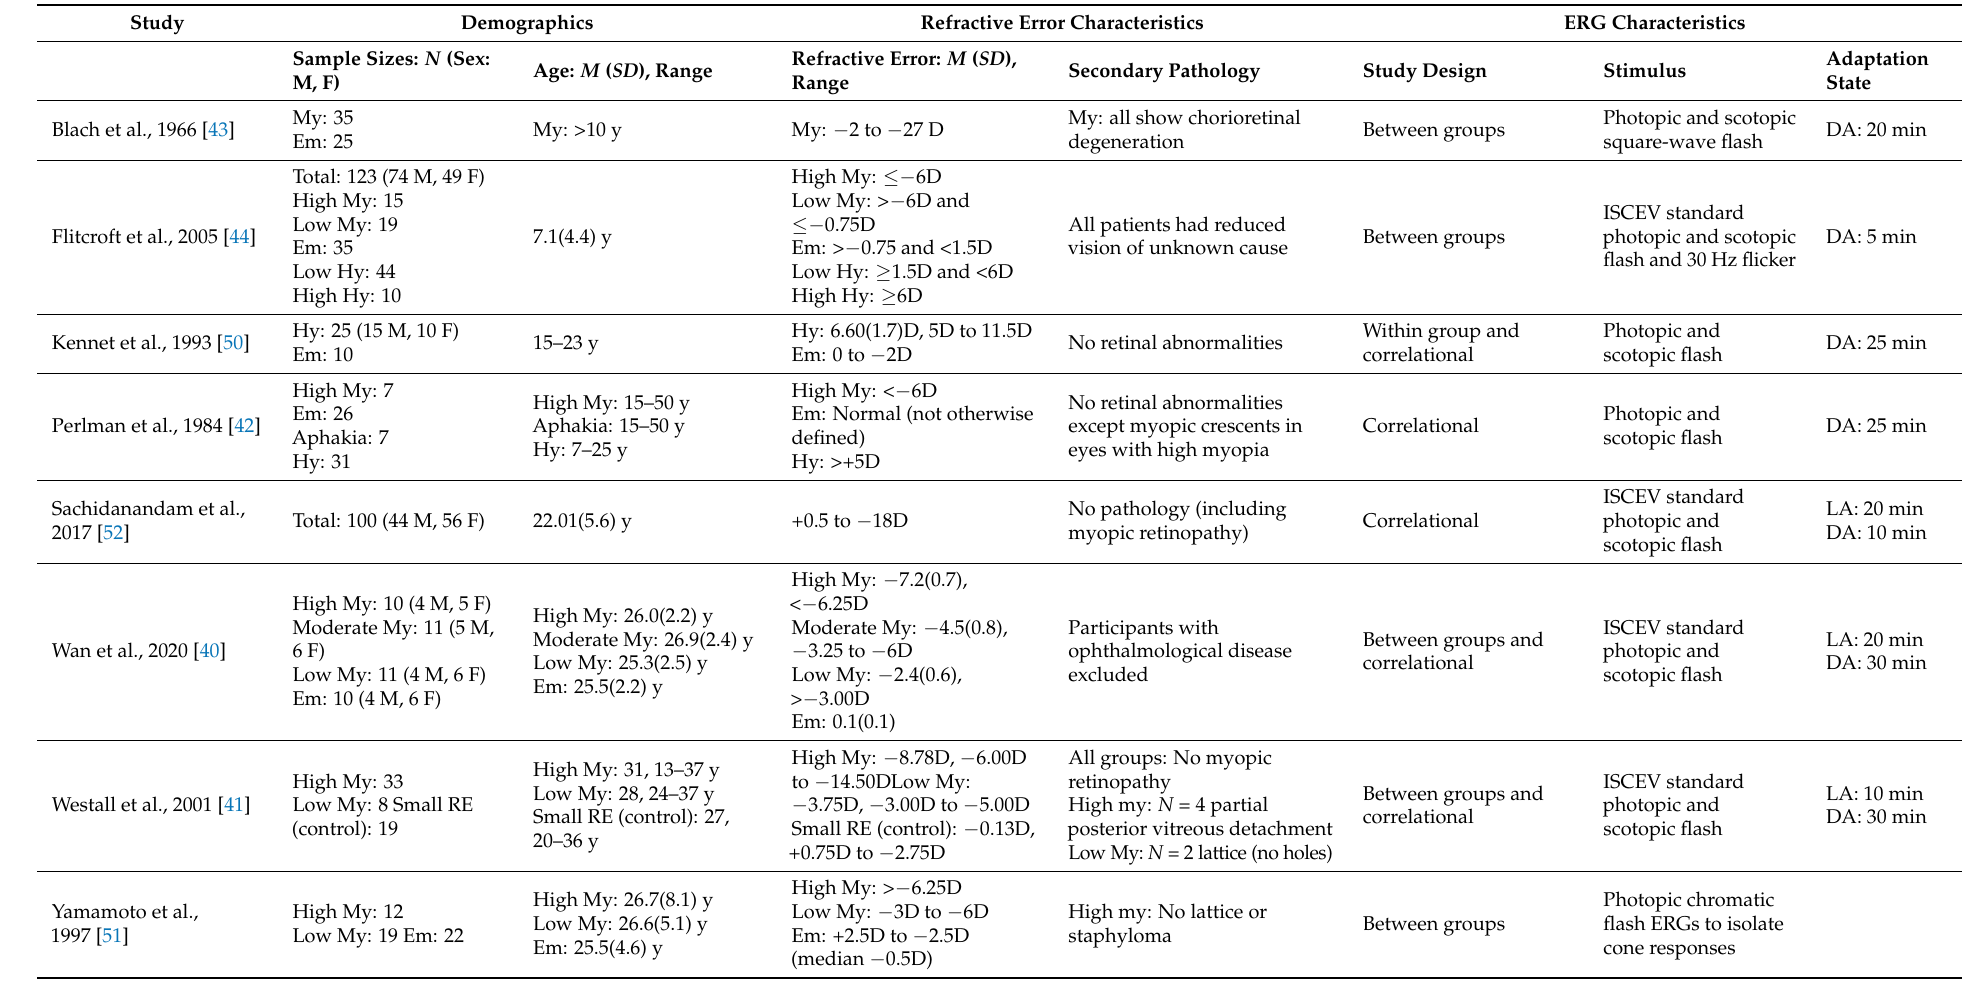
Table 6. Characteristics of Included